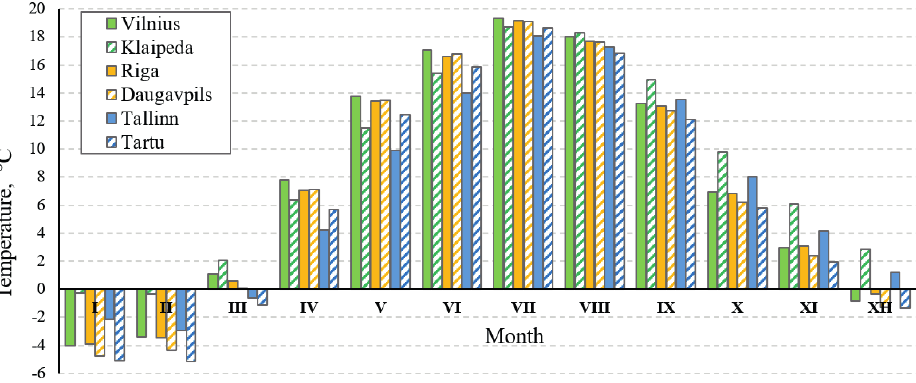
Fig. 3. Monthly average air temperatures for six